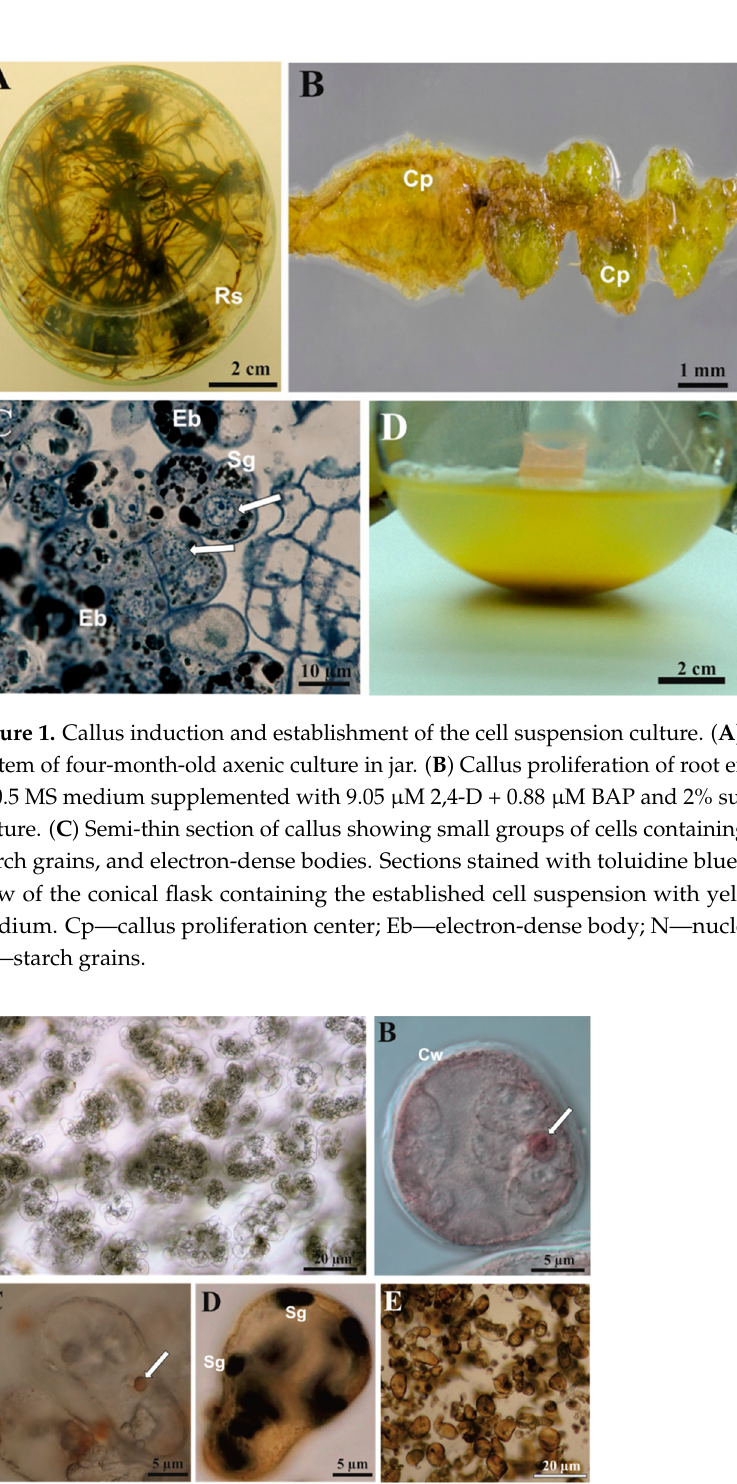
Figure 2. Cell suspension of C. smithii cultured in ½ MS medium supplemented with 9.05 µM 2,4-D + 0.88 µM BAP observed with Nomarski contrast. ( A ) General view of the cell aggregates. ( B ) Single cell with nucleus and distinct nucleoli stained with acetocarmine. ( C ) Lipid body (arrow) stained with Sudan III. ( D ) The cell showing numerous individual starch grains stained in black-blue coloration with in IKI. ( E ) Structure degradation of the ordered cell suspension by the subculture extension. Cw—cell wall, Sg—starch